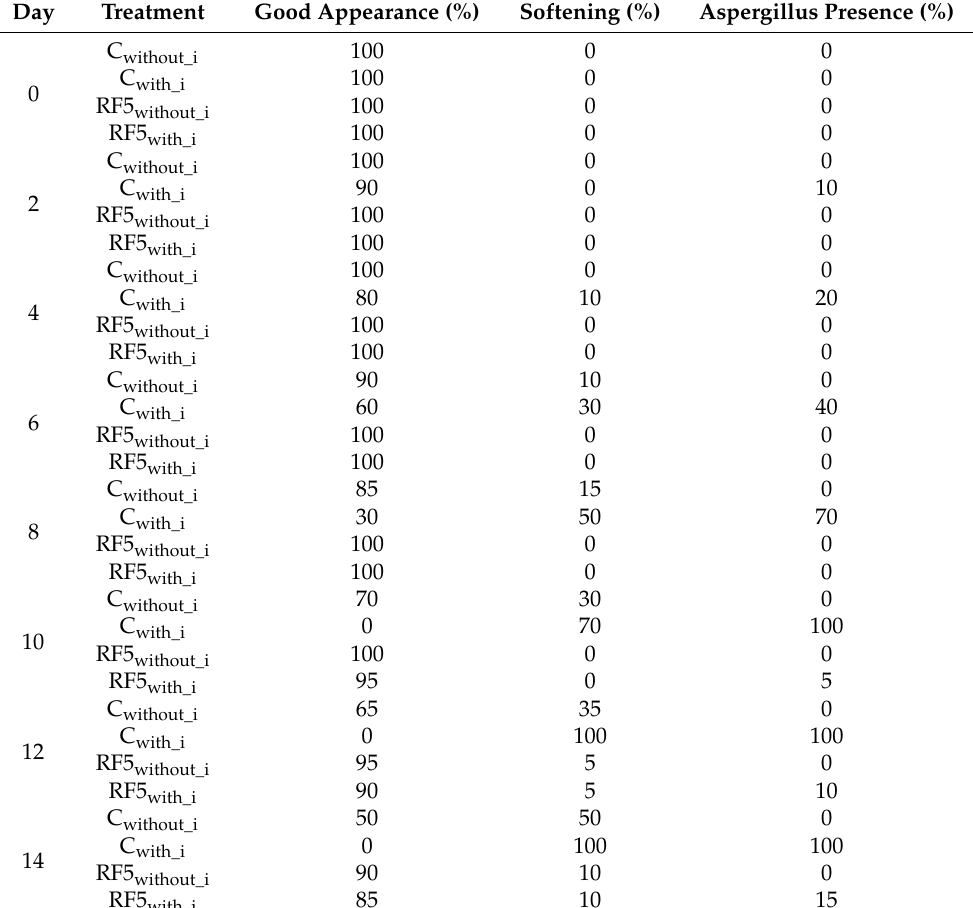
Table 6. Strawberry inoculated with Aspergillus niger : samples without coating (C without_i : Uninoc- ulated and uncoated; C with_i : Inoculated without coating) and samples with coating (RF5 without_i : without inoculum and with coating; RF5 with_i : inoculated and coated) stored at 85% RH and 25 ◦ C for two